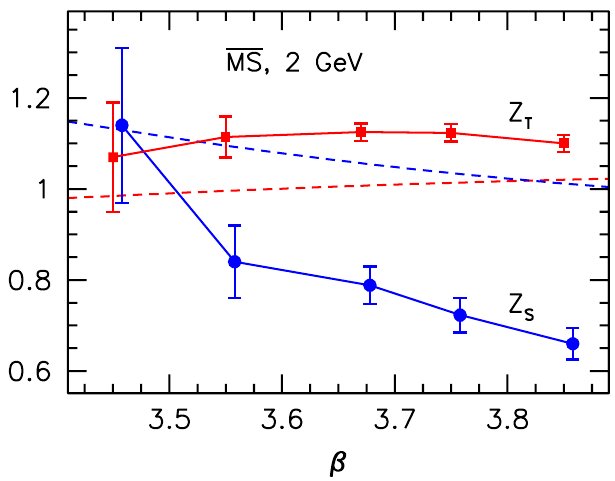
Figure 11 . Multiplicative renormalization constants as a function of (cid:12) . The symbols have been slightly shifted horizontally for better visibility and connected by lines to guide the eye. Also shown as dashed lines are the one-loop perturbative expectations [26] that will be approached as (cid:12) ! 1